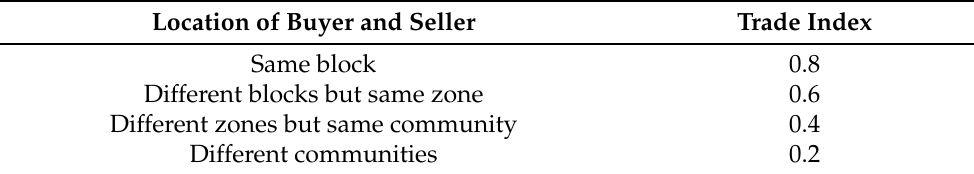
Table 1. Trade index for different prosumer–consumer